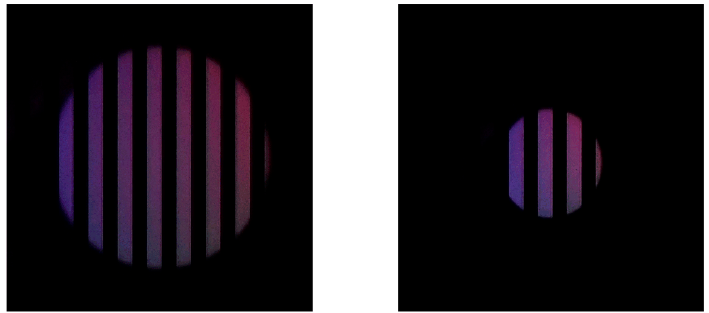
Figure 5. The effect of the distance between LED and CMOS camera.